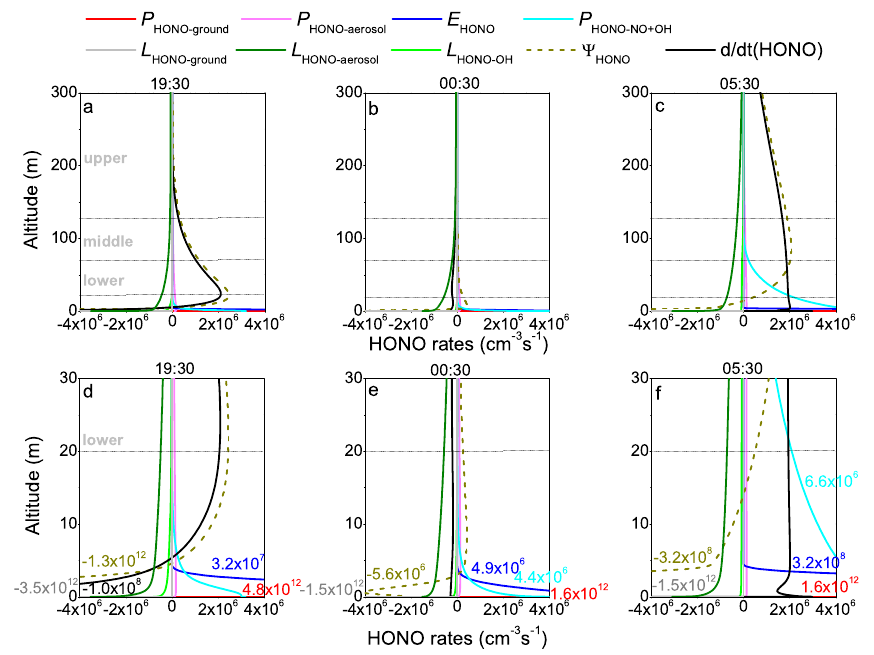
Fig. 9. Modeled vertical profiles of HONO rates at 19:30 CST (a , d) , 00:30 CST (b , e) and 05:30 CST (c , f) during the night of 1–2 September 2006. Panels (a) , (b) , and (c) show the lower 300m of the atmosphere. Panels (d) , (e) , and (f) provide a closer view of the lowest 30m of the atmosphere. Numbers in these panels apply to the maxima of the respective processes in the lowest meter above the ground.